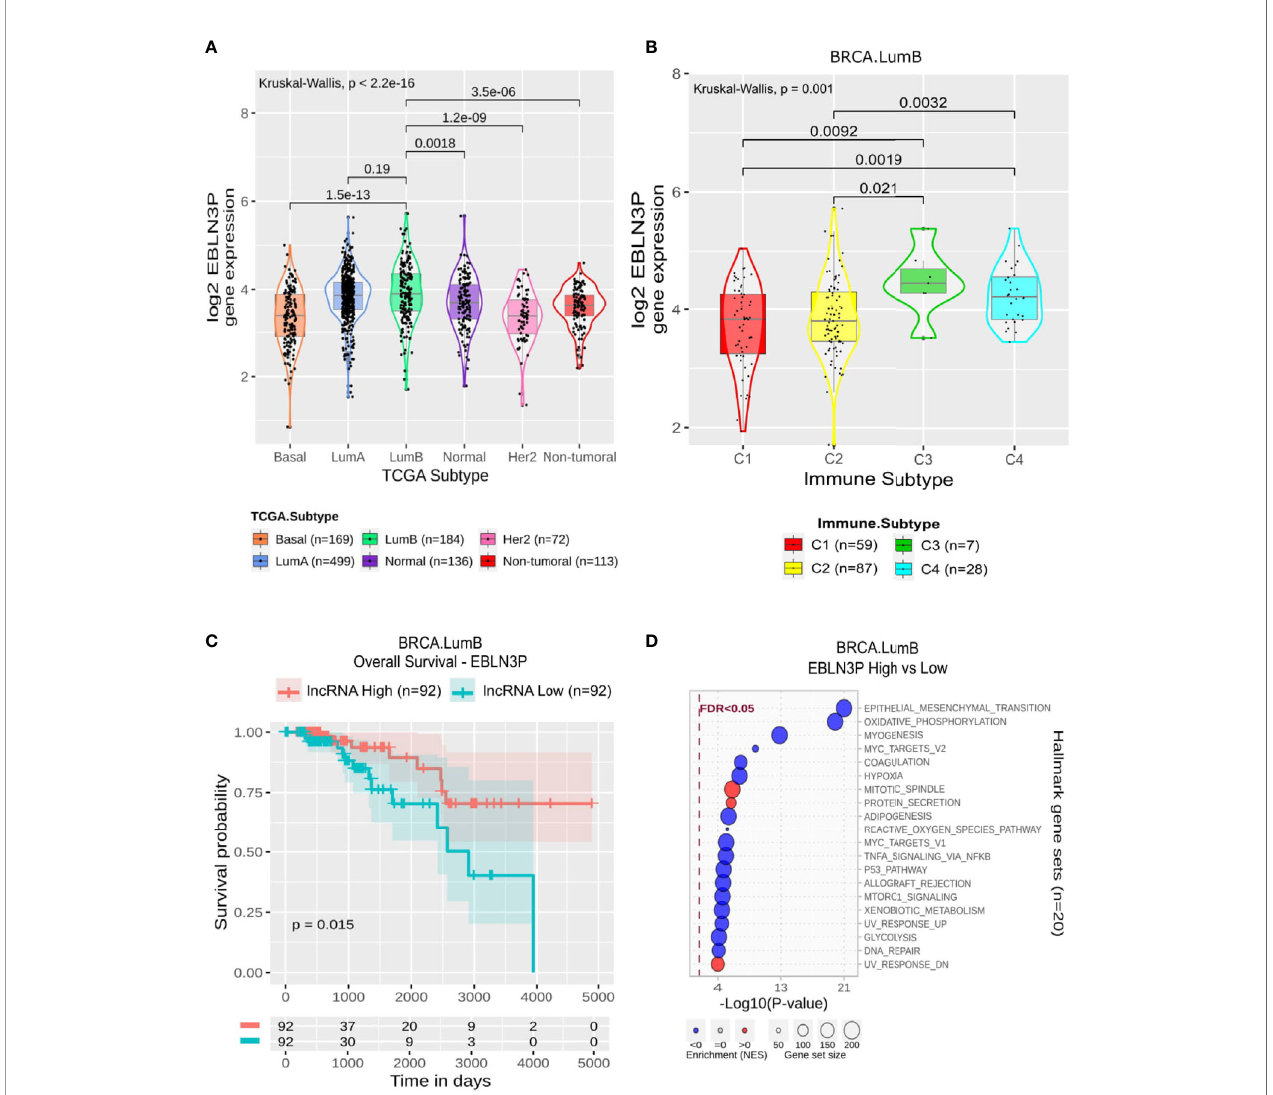
FIGURE 7 | EBLN3P panel representation in LumB subtype. (A) Box-plots representing EBLN3P expression among all breast cancer molecular subtypes. The Kruskal-Wallis test (p-value represented in the panel left top position) was used to differentiate expression between groups, followed by the Wilcoxon test (p-values represented emphasizing comparisons between subtypes). (B) Box-plot representing EBLN3P in C1,C2, C3, and C4 immune subtypes in LumB patients. (C) EBLN3P overall survival curves. To de fi ne the two groups, EBLN3P ’ s median expression classi fi ed the patients into “ high ” and “ low ” groups. Logrank p-value represented as 0.015. (D) Enrichment analysis using Hallmarks gene sets. Red circles refers to activation while blue circles to inactivation. In X axis, a p-value scale is represented. The circle size varies according to the number of genes in the identi fi ed gene